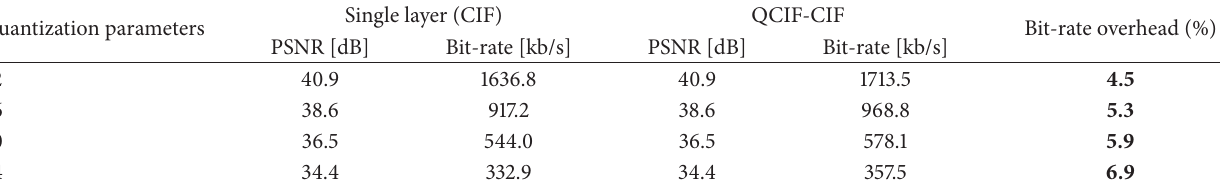
Figure 4: Additional examples of the ROI dynamic adjustment and scalability by using a cropping method. Table 1: Two-layer (QCIF-CIF) spatial SVC coding versus single layer (CIF) coding (“ SOCCER ” video sequence, 30fps, 300 frames, GOP size is